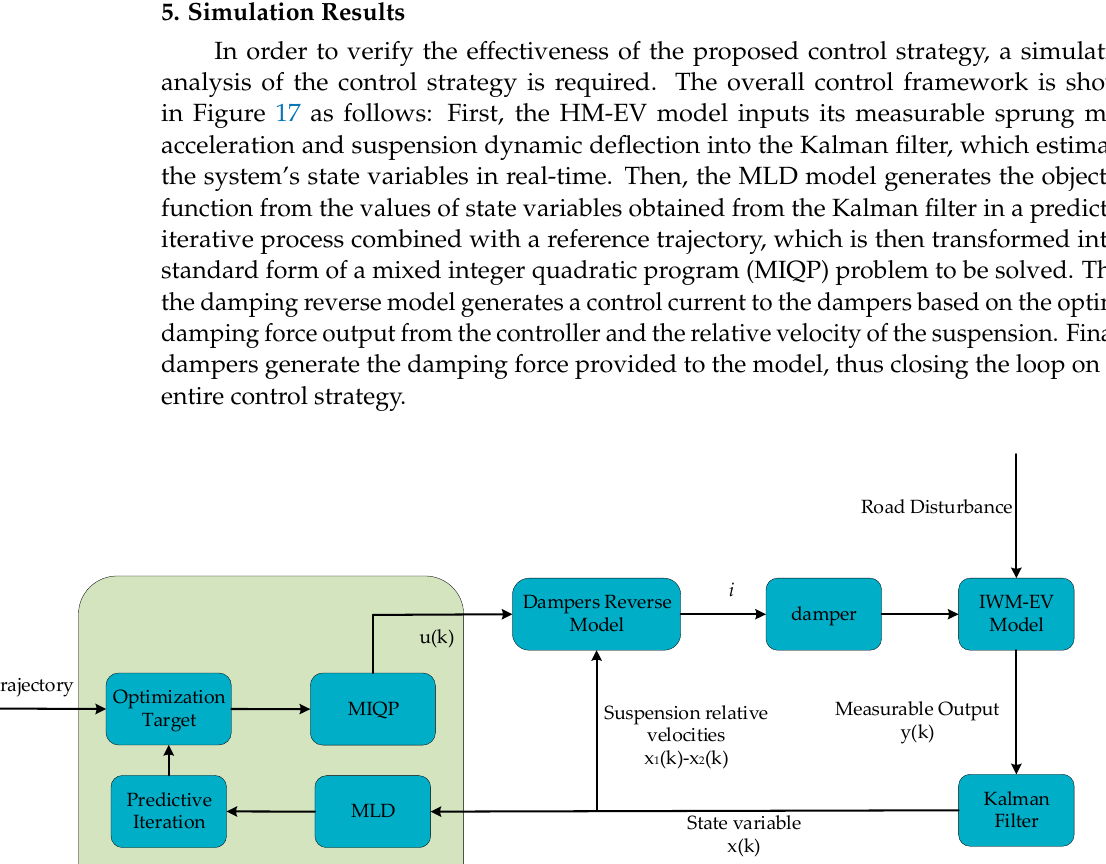
Figure 17. Hybrid model predictive controller (HMPC) control scheme.